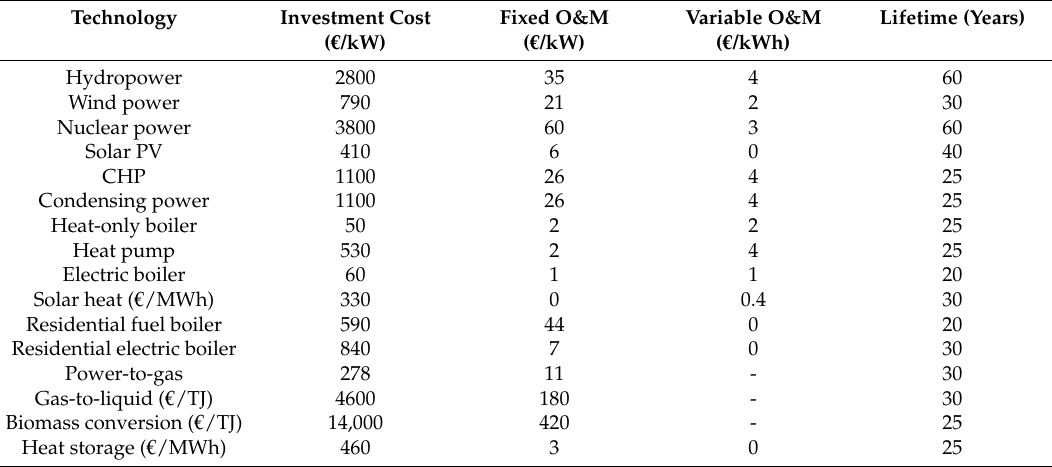
Table A3. Assumed technology costs in 2050, based on References